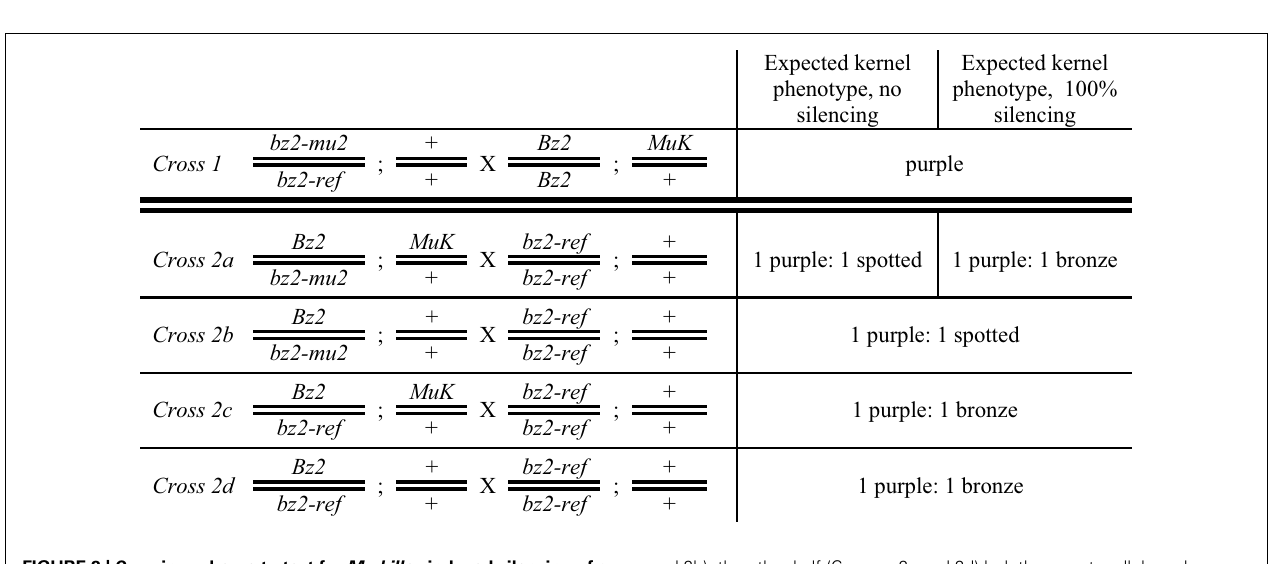
FIGURE 2 | Crossing scheme to test for Mu killer -induced silencing of a high copy mutator line. Half of the progeny ears contain the bz2-mu2 reporter allele and are expected to segregate 1:1 purple:spotted (Crosses 2a